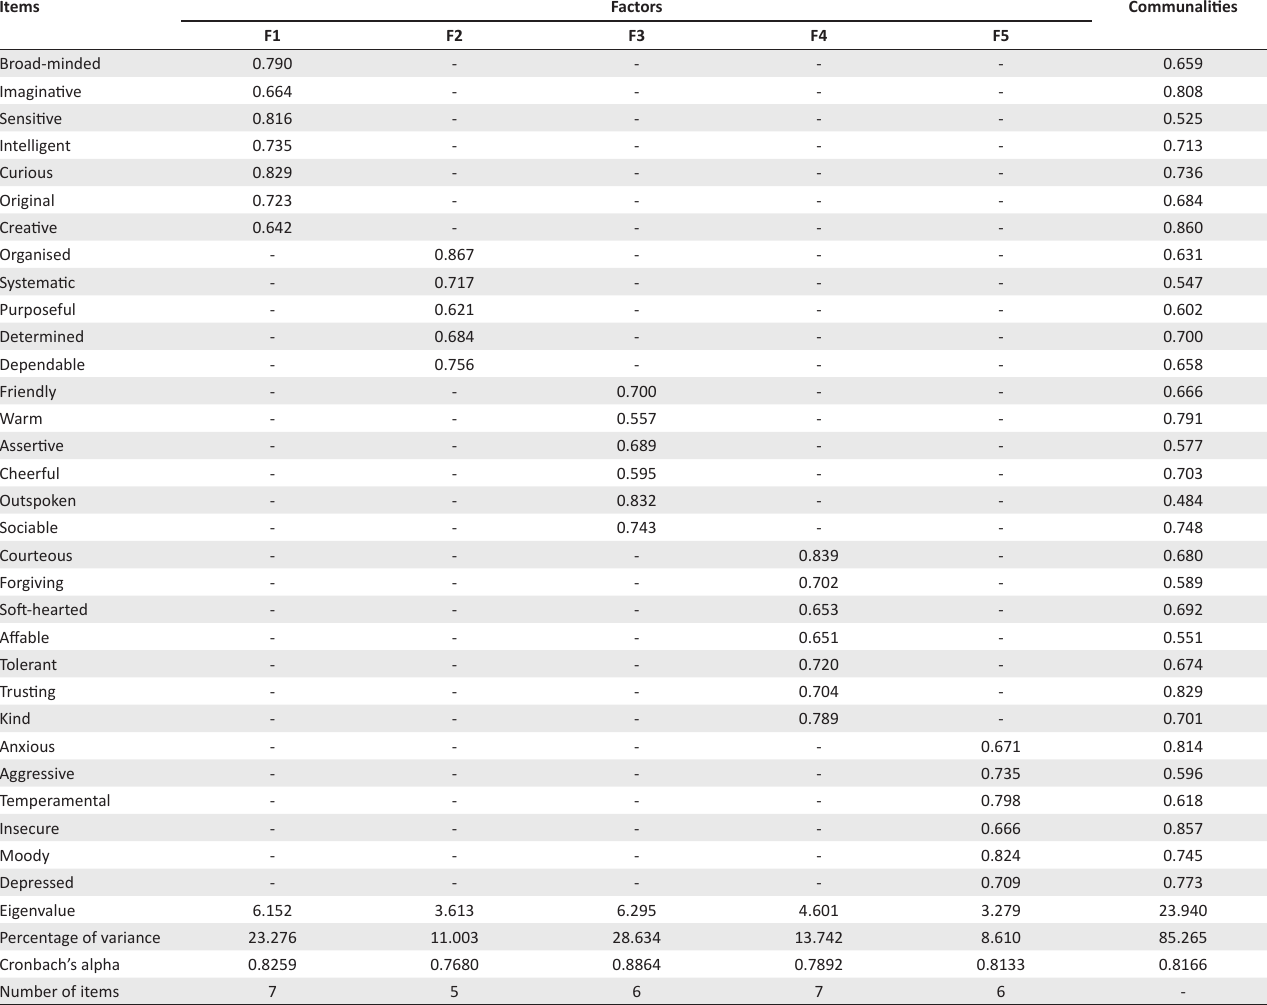
TABLE 3: Factor and reliability analysis results of the personality attributes affecting entrepreneurial performance. Items Factors